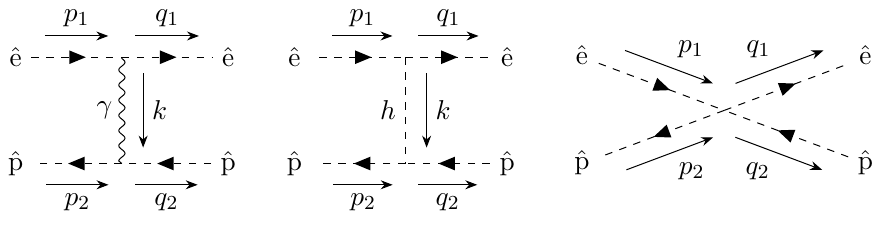
Figure 1 . The three tree level diagrams of ˆe ˆp